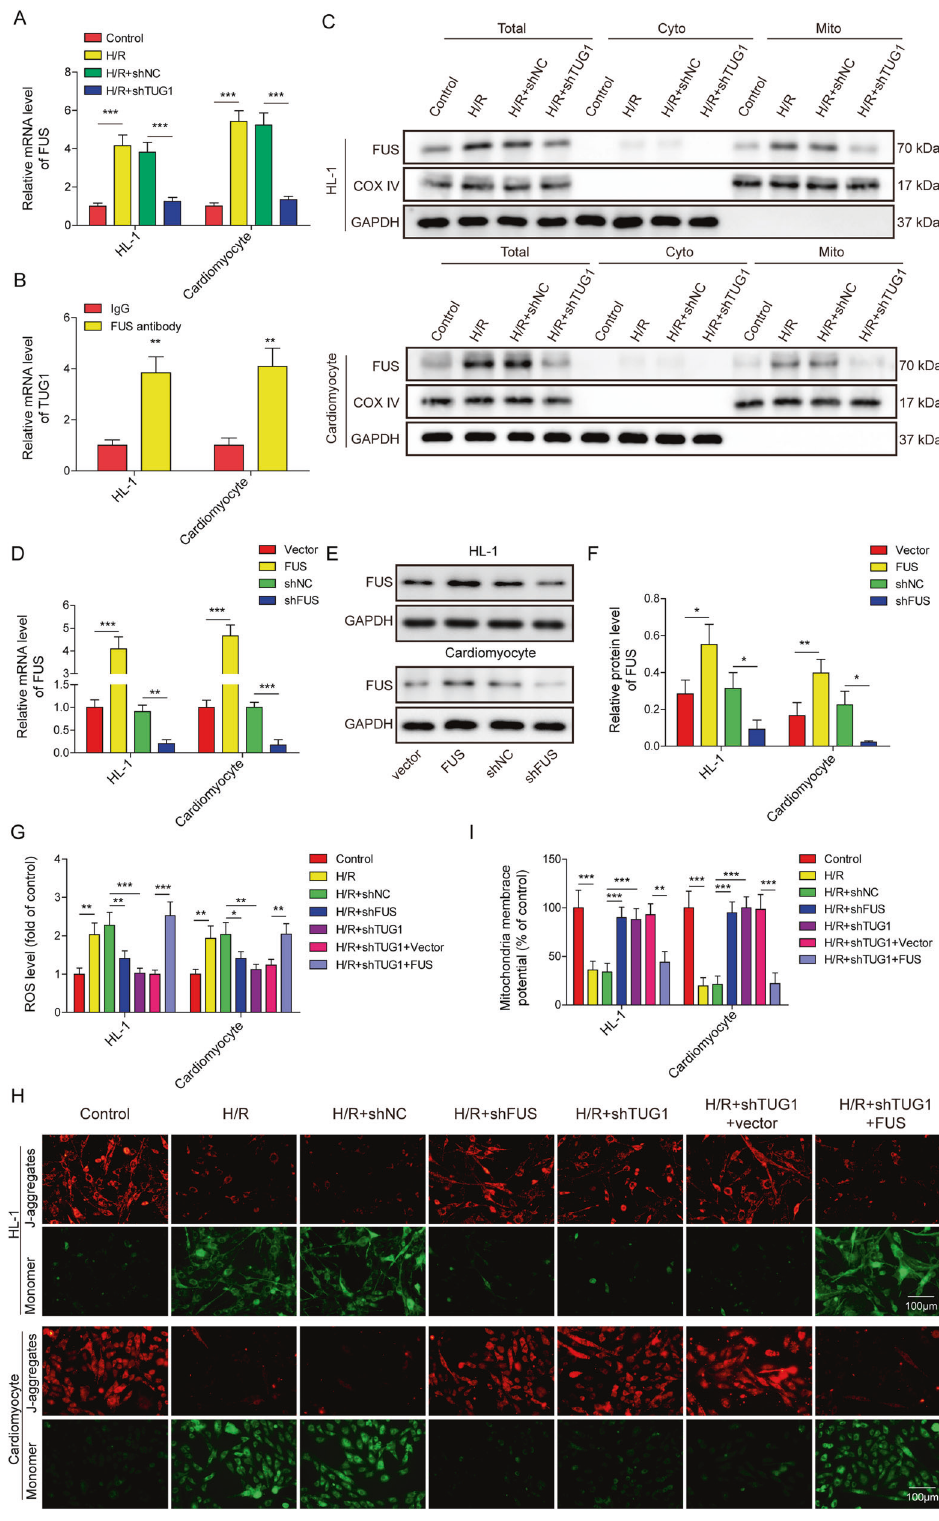
Fig. 4 TUG1 promoted FUS expression by directly binding to the molecules, and overexpression of FUS reversed the effects of TUG1 silencing on H/R-induced mitochondrial dysfunction in cardiomyocytes. A qRT-PCR measurement of FUS levels in H/R-treated cardiomyocytes transfected with shTUG1 or shNC. B RIP assay on the presence of TUG1 in cardiomyocyte samples pulled down by antiFUS antibody or control IgG. C Western blotting measurement of FUS expression in the cardiomyocytes cytoplasm, mitochondrial fraction. The D mRNA and E , F protein levels of FUS were measured using qRT-PCR and western blotting in cardiomyocytes transfected with shFUS, shNC, vector expressing FUS, or empty vector. G ROS levels were measured using a DHE assay. H , I Mitochondrial membrane potential was evaluated using JC-1 staining. * P < 0.05, ** P < 0.01 and *** P <